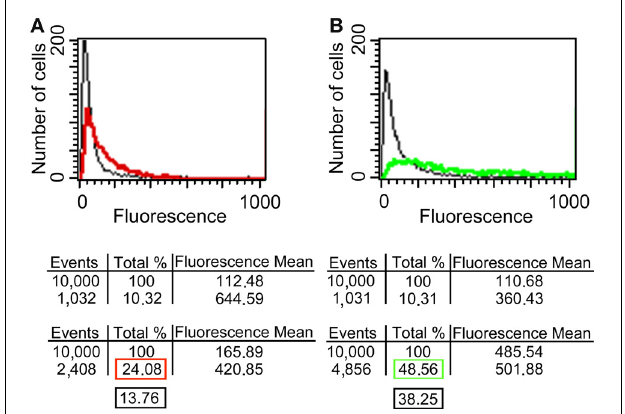
FIGURE 2 | Flow cytometry of enolase detected on yeast surface and in the whole cell. (A) C. albicans SC5314 fixed and non-permeabilized cells were incubated with anti-His 6 -Enolase polyclonal serum (1:80), present slightly higher fluorescence (red line) than the relative fluorescence background of the untreated control cells (black line). (B) C. albicans SC5314 fixed and permeabilized cells with saponin 1% exhibit higher fluorescence (green line) compared with non-permeabilized cells. 10 4 cells were analyzed per experiment. On average, 10% of them exhibited autofluorescence that were discounted of the experimental measurements highlighted in the red (non-permeabilized cells) and green (permeabilized cells) boxes in the final analysis. Black boxes depict the subtraction of fluorescence by autofluorescence values (Approximately 14 and 40% for non-permeabiled and permeabilized cells,